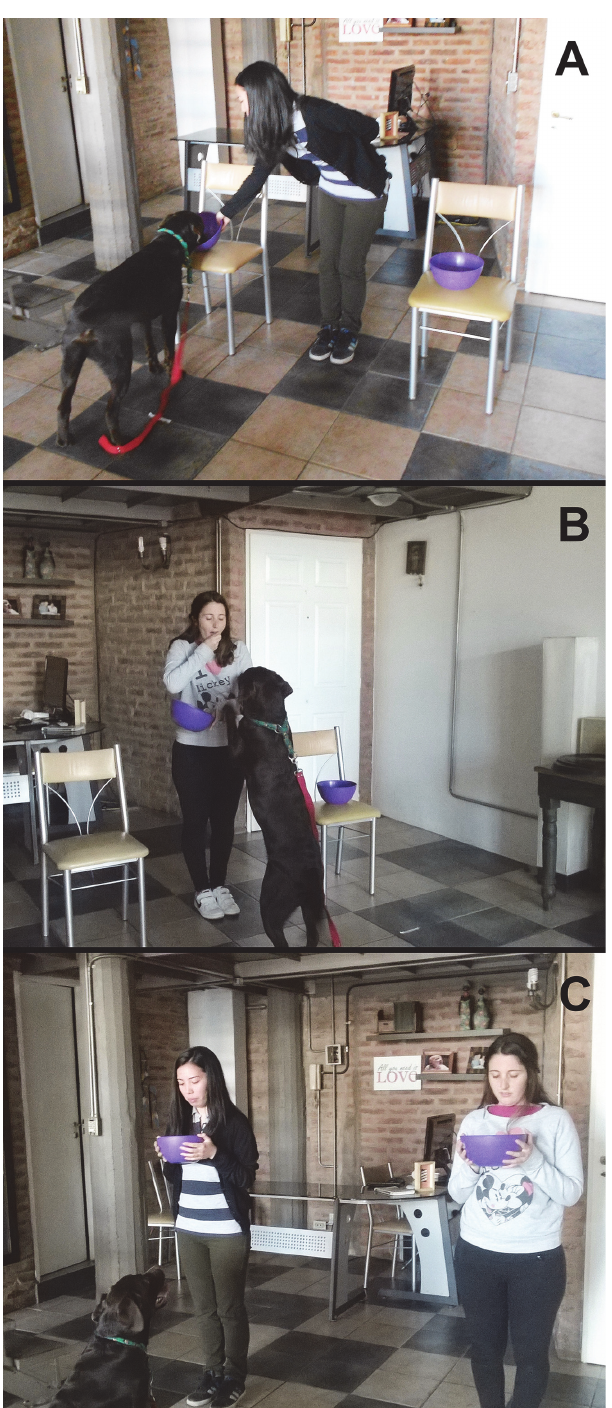
Fig 1. Photos of the experimental set up and procedure. (A) The generous experimenter is letting the dog eat from the baited bowl. (B) The selfish experimenter is eating the food in front of the dog. (C) Experimental set up in choice tests; the dog is approaching the experimenter on the right. All persons that appear in this figure have given written informed consent, as outlined in the PLOS consent form, to publication of their